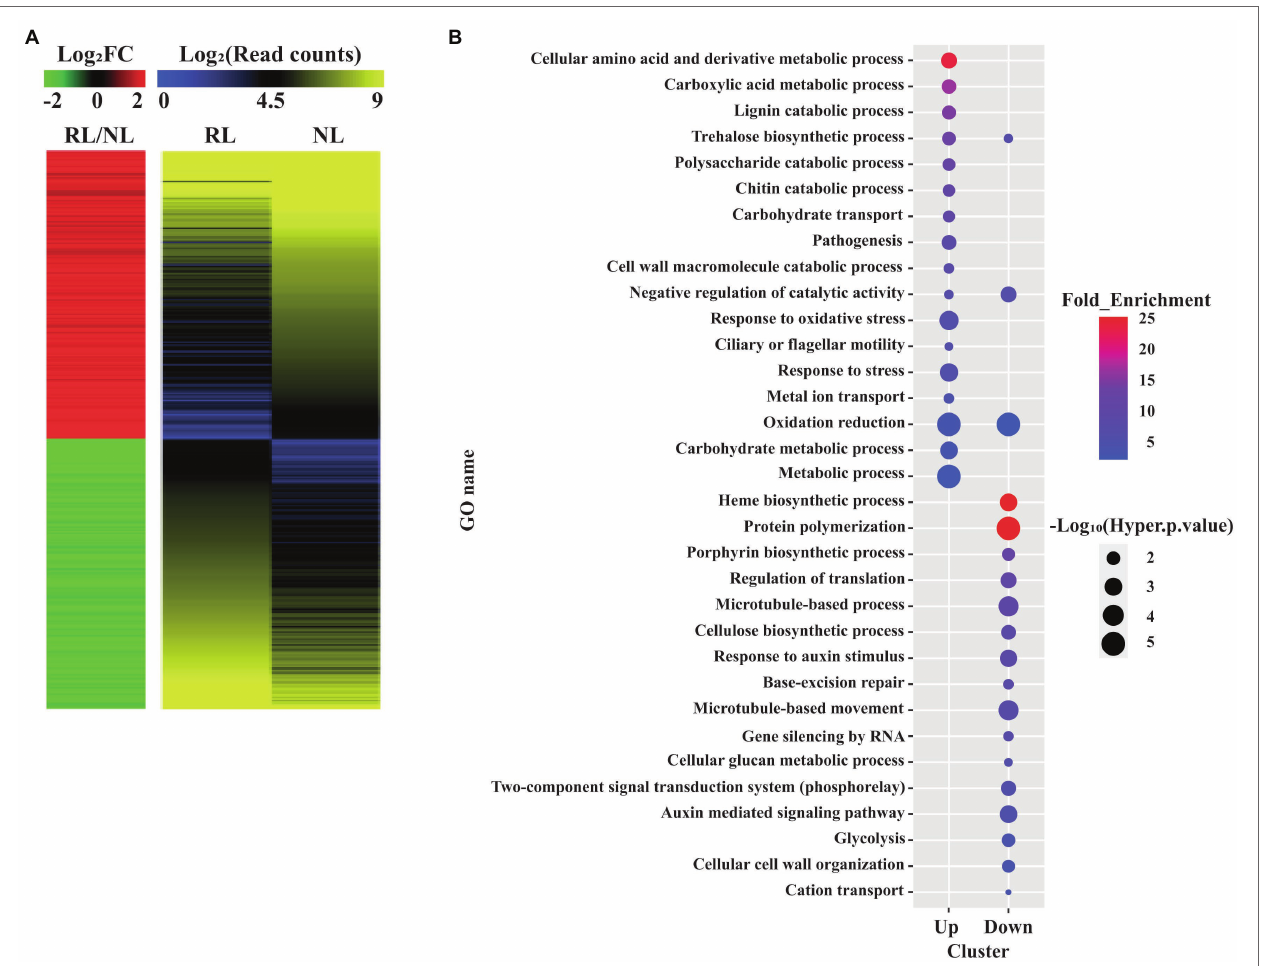
FIGURE 2 | Gene ontology (GO) enrichment analysis of differentially expressed genes (DEGs) detected in the developing seeds of Samgwang grown on reclaimed land (RL). (A) Heatmap analysis of the DEGs. A total of 491 up or downregulated DEGs between normal land (NL) and RL were visualized. Both heatmaps were generated by using average values of four replicates in the transcriptome analysis. The red and green colors in the left panel indicate up and downregulated DEGs, respectively. The Log 2 FC (FC, fold change) and Log 2 (Read counts) indicate the Log 2 transformed value of normalized read counts and fold change (RL/NL), respectively, which was generated by RNA-seq. (B) GO enrichment analysis of the 491 DEGs. GO terms based on the biological process were visualized as the dot plot. Dot color and size represent fold enrichment value (query number/query expected value in selected GO term) and − Log 10 (Hyper value of p ). The redder and larger dots indicate statistically significant enriched GO